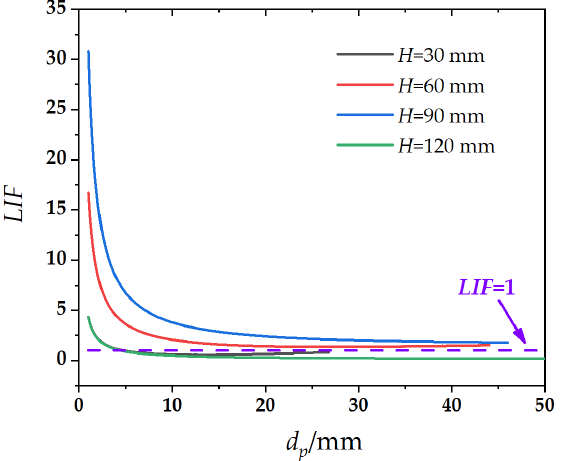
Figure 16. Relation between lift index and particle diameter under four different H / d p .